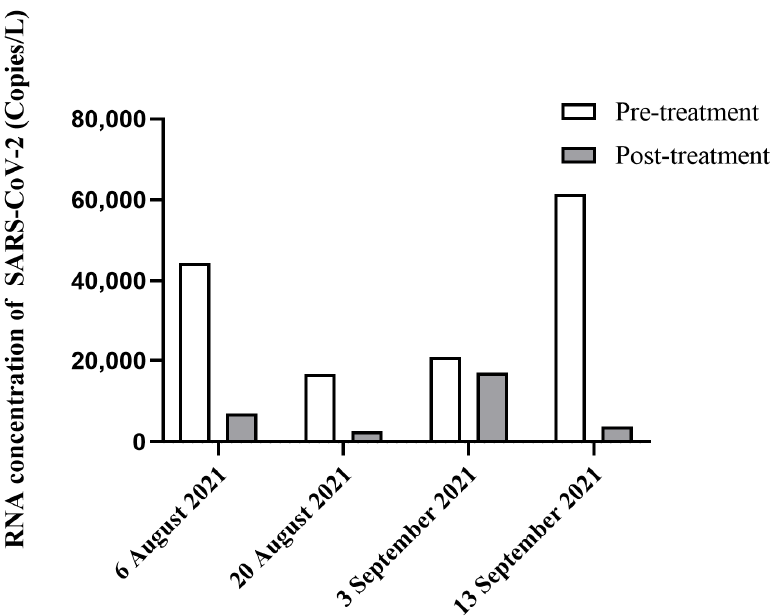
Figure 3. Average SARS-CoV-2 RNA concentration between the pre- and post-treatment pro- cesses.